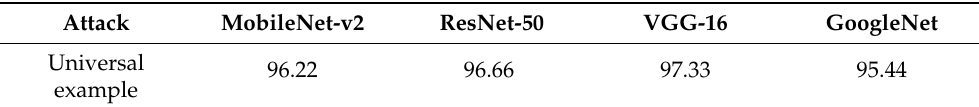
Table 3. Transferability—represented by attack success rate (%)—of universal adversarial examples among different deep learning models.